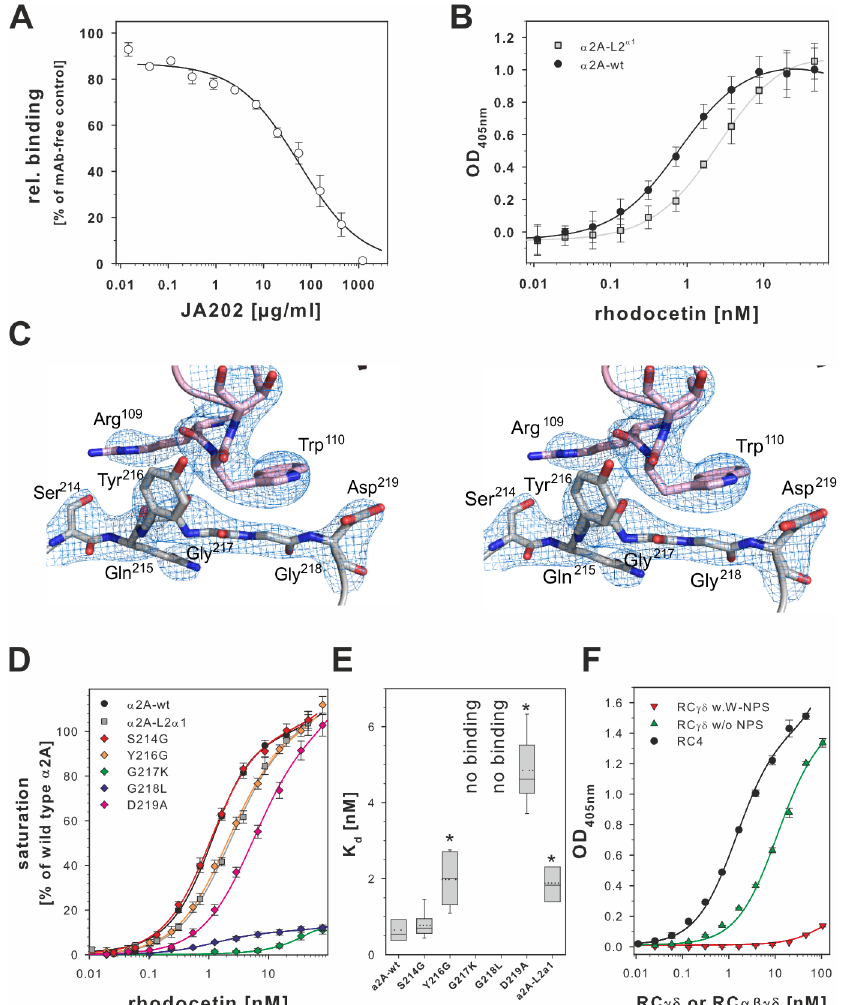
Fig 7. Loop 2 of the α 2Adomain is the interaction site for the RC γ subunit. ( A )Loop2 of α 2Ais an additional bindingsite for rhodocetin (RC). It containsthe epitopefor the monoclonalantibody (mAb) JA202, whichinhibitsbindingof RC to immobilized α 2A.BoundRC was quantified by ELISA, and valueswere normalizedto noninhibited controls. One set of inhibitioncurves out of 3 independent experimentswith each measurement made in triplicateand the means ± SD for each datapoint are shown.( B )The α 2Aloop2 sequencewas replacedwith the homologous sequenceVGRGGRQ of integrin α 1( α 2AL2 α 1 mutant). The binding-irrelevantantibodyJA218was immobilized to capturewild-type(wt) α 2Aand α 2AL2 α 1 . They were titratedwith RC, and boundRC was quantified as in ( A ).One set of titrationcurves out of 4 independent experiments, each donein triplicates, is shownwith the means ± SD indicated.The α 2AL2 α 1 mutant (light gray ■ )significantlyreducedaffinity for RC compared to the wt ( ● )( p = 0.0013,two-tailed t test) ( C )Stereo view of the α 2Aloop2 sequence in contact with the RC γ contact site. The Sigma-Aweighted2Fo-Fc map is shownat 1.5 σ contourlevel. The 2 glycineresidues,G217 and G218, form the bottom of a shallowdimple, whichis flankedon eitherside by the sidechainsof Y216and D219,in addition to residueN154 of loop1 (not shown). The indoleside chainof W110 γ stacks directlyabovethis dimpleand interacts with the mainchainof the 2 glycineresidues.( D )Point mutationanalysisof the α 2Aloop2 sequenceS 214 QYGGD 219 . The bindingactivity of these mutants for RC was tested as in ( B ).Bindingsignalstaken from at least 7 independent titration curves for eachmutant werenormalizedto the saturationsignalof wild type α 2A.Means ± SEM are shownfor the mutants ( ◆ of different colors)in comparison to wt ( ● )and the α 2AL2 α 1 mutant (lightgray ■ ).This analysis showedthat the 2 glycinesat position217 and 218 werekey to the RC γδ - α 2Ainteraction, as onlymutations abrogated α 2Abinding.( E )The K d valuesof the loop2 point mutationsfor bindingto RC as derivedfrom ( D ).At least 7 titrationcurveswere evaluatedfor eachmutant. The K d valueswere pairwisecompared to the K d value of the wild type α 2Adomainin a two-tailedStudent t test. Significantdifference( p < 0.02)is asterisked ( * ).( F ) Modification of tryptophanresiduesof RC γδ with 2-nitrophenyl sulfenylchloride(NPS-Cl) showedthat W110 γ